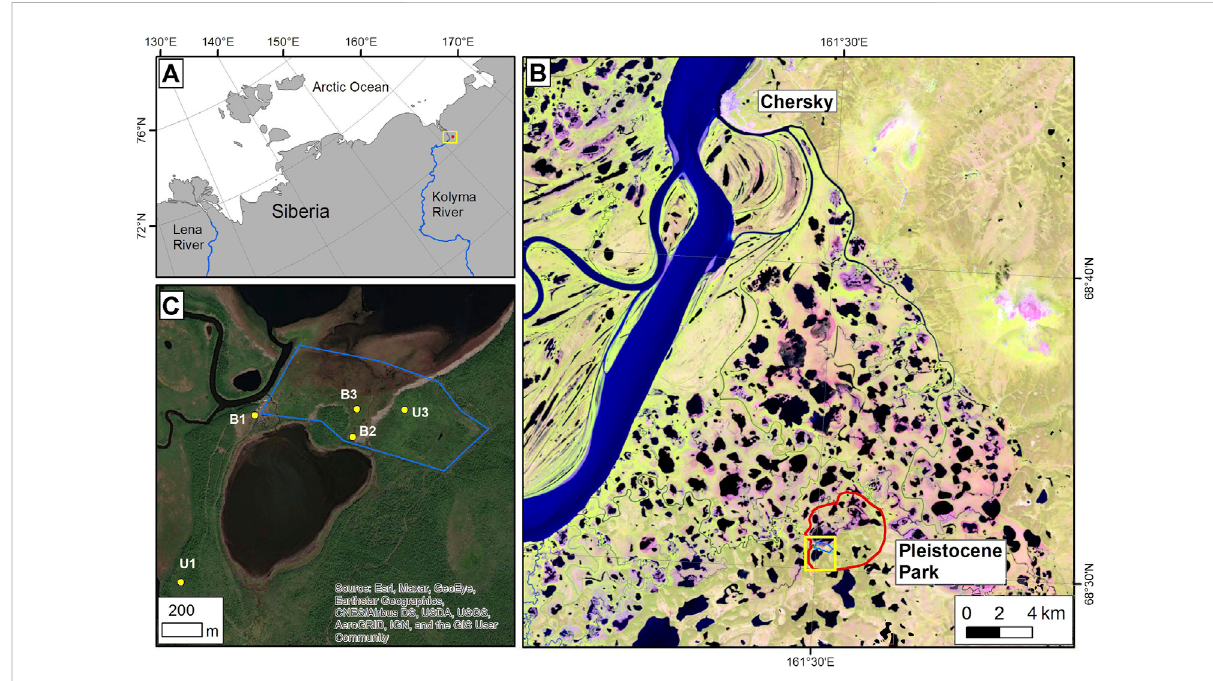
FIGURE 2 Location of the study area in northeastern Siberia marked with a yellow frame (A) . In the Landsat-8 satellite image (band combination of shortwaveinfrared1-nearinfrared-red,2019-07-04)ofpanel (B) theredlinemarkstheareaofPleistoceneParksouthofChersky;theyellowframe indicates thelocationofthe fi eldstudy sitesshown in (C) . Panel (C) showsahigh resolution GeoEye satellite image(2018-07-21; ArcGIS Online base map provided by the Environmental Systems Research Institute, ESRI) with Pleistocene Park fences (blue) and sampling sites labeled as B, indicating drained basin sites, and U, indicating Yedoma upland sites; numbers indicate the grazing intensity of each site, from 1 (no grazing) to 3 (intensive